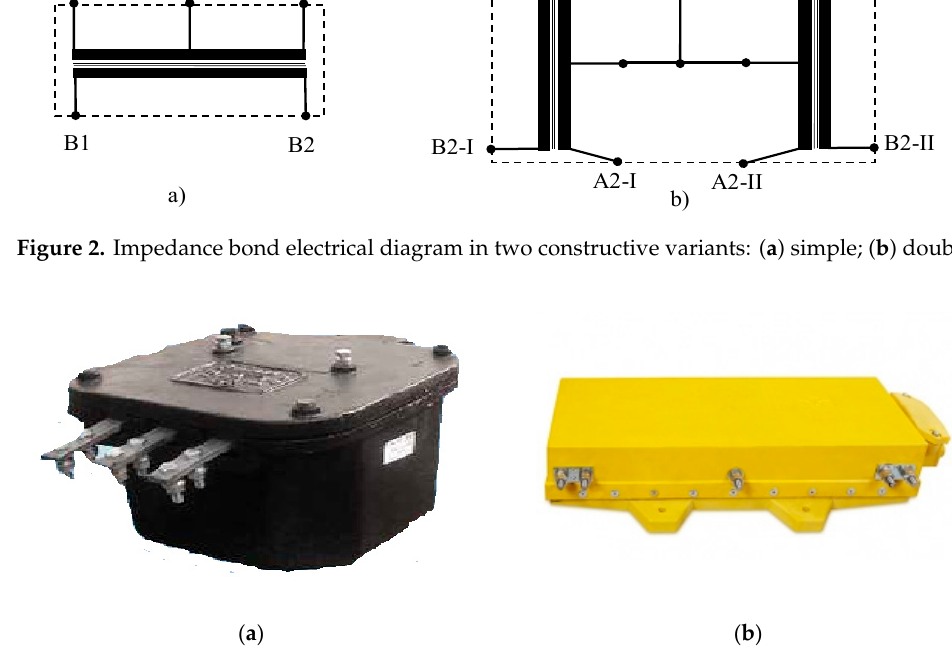
Figure 3. Image of impedance bonds: ( a ) simple in cast iron casing; ( b ) double in a non-metallic housing.